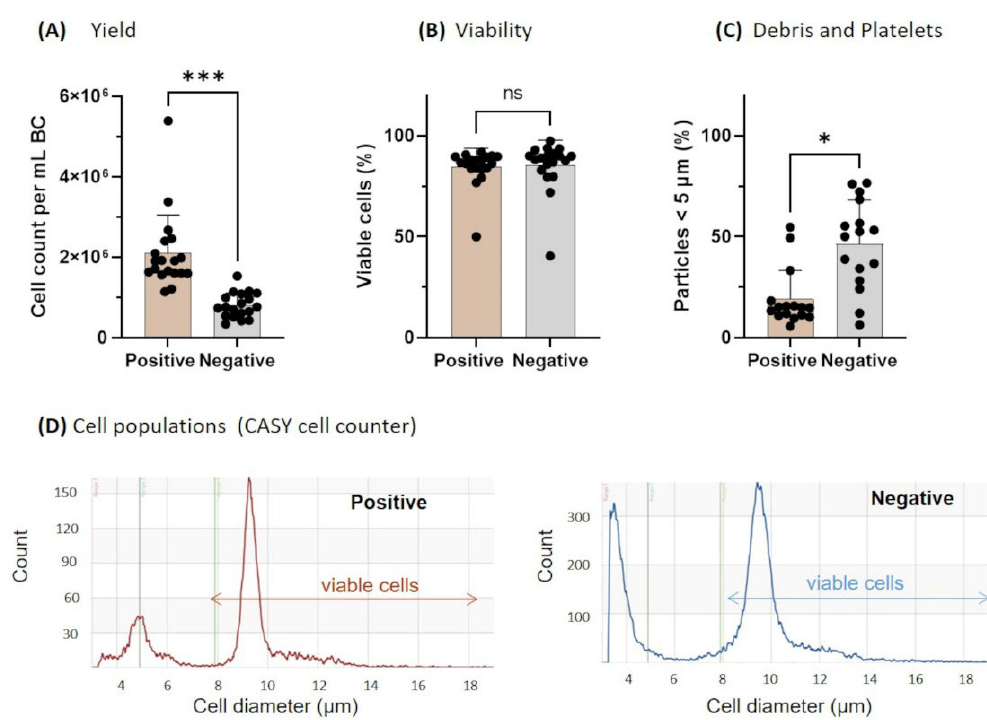
Figure 2. Effect of positive and negative isolation on yield ( A ), viability ( B ), and debris/platelets ( C ) measured by CASY cell counter and calculated as described [22]. A representative cell count vs. cell size profile after positive or negative selection is shown in ( D ). ( A – C ): Results are presented as single dots for each BC and as Means + SD. Pairwise comparisons were calculated with the Wilcoxon matched-pairs signed rank test. ( A – D ): n = 19; *** p < 0.001, * p < 0.05, ns = not significant.